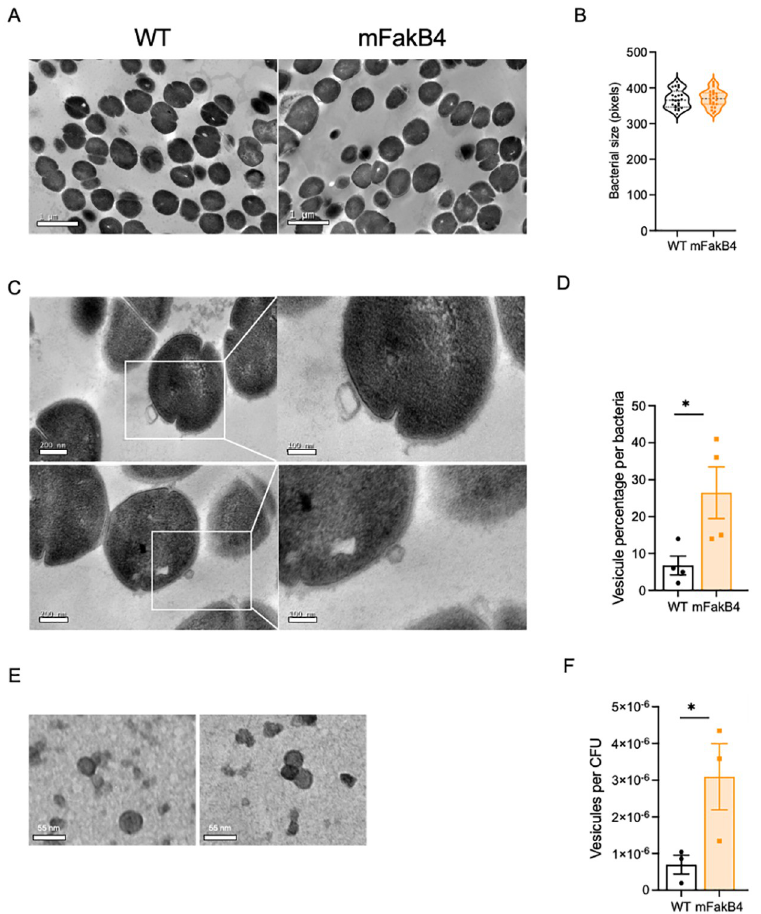
Fig 4. The mFakB4 strain secretes extracellular vesicles. A, C) TEM images of bacterial sections, left WT, right mFakB4; A) 4000X, C) 15000X, inset 30000X (scale = 200 nm; inset scale = 100 nm); B, D) Image analysis, B) bacterial diameter length, N = 4, 24 independent images, D) percentage of vesicles per bacteria, N = 4, 67 independent images. E) TEM images, of extracellular membrane vesicles contained in mFakB4 culture supernatant (scale = 40 nm); F) Image analysis N = 3, 30 independent images. B, D, F) One-way ANOVA, Bonferroni post-test, * p < 0.05.